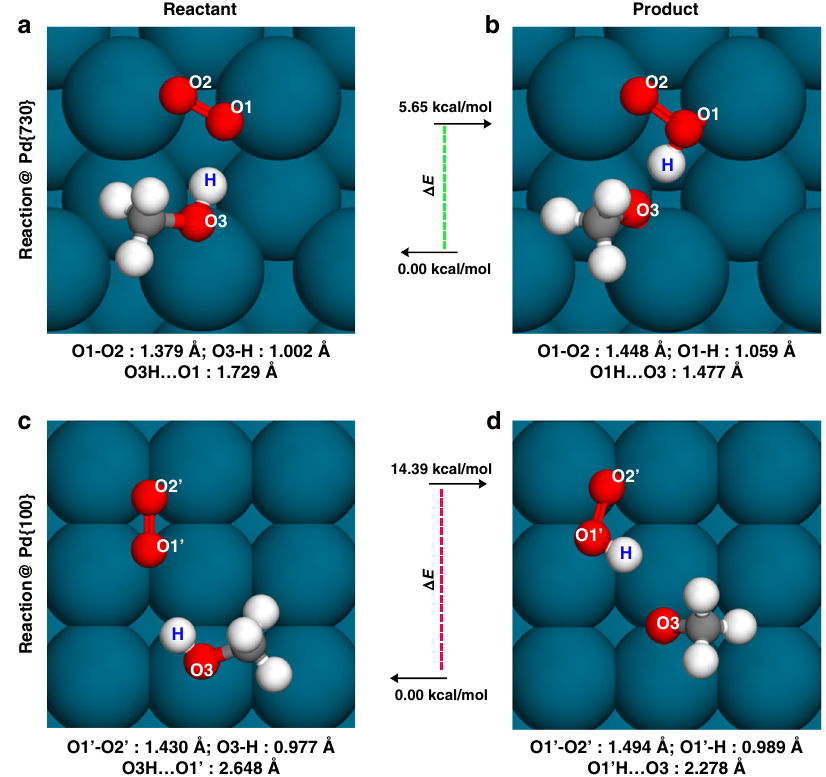
Fig. 4 Simulated CH 3 OH oxidation on Pd{730} and Pd{100} surfaces. a – d represent the optimized structures of the reactants and the products on Pd {730} and Pd{100} surfaces. The Δ E values indicate the energy requirements of the endothermic also tended to be adsorbed by a ridge of Pd{730}, forming a very short hydrogen bond of 1.729 Å with O 2 @Pd{730}. Hydrogen bond interaction between the hydroxyl group of CH 3 OH and O 2 @Pd{730} is enhanced by a high density of negative charge on